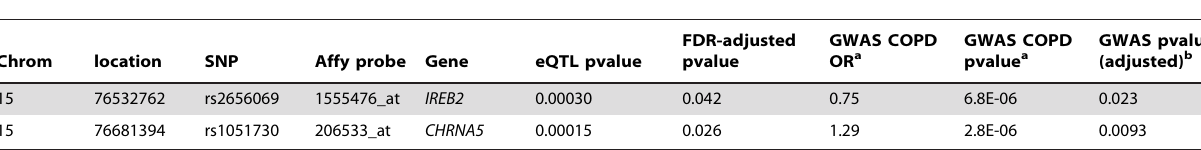
Table 2. Sputum cis-eQTL SNPs significantly associated with COPD in the combined COPD GWAS.